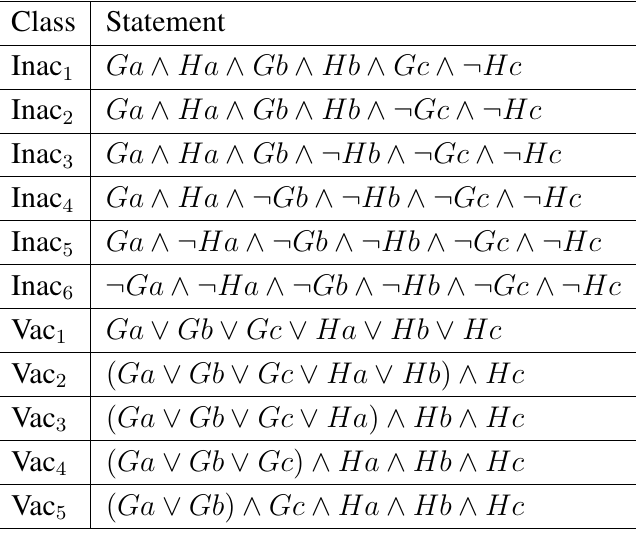
Table 3. Classes of inaccuracy and vacuity